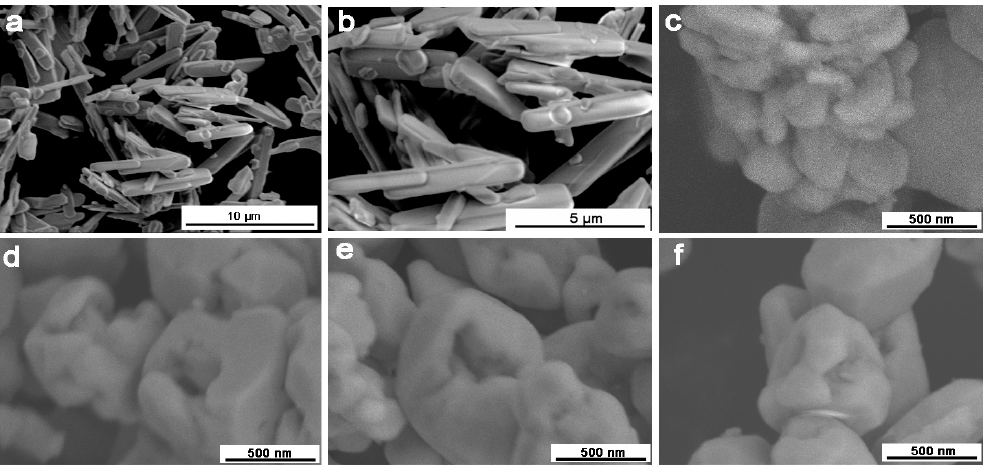
Figure 2. SEM images of the precursor ( a , b ); BiVO 4 particles ( c ); and as-obtained BiVO 4 products prepared at the hydrothermal temperatures of 180 °C ( d ); 200 °C ( e ); and 220 °C ( f ).